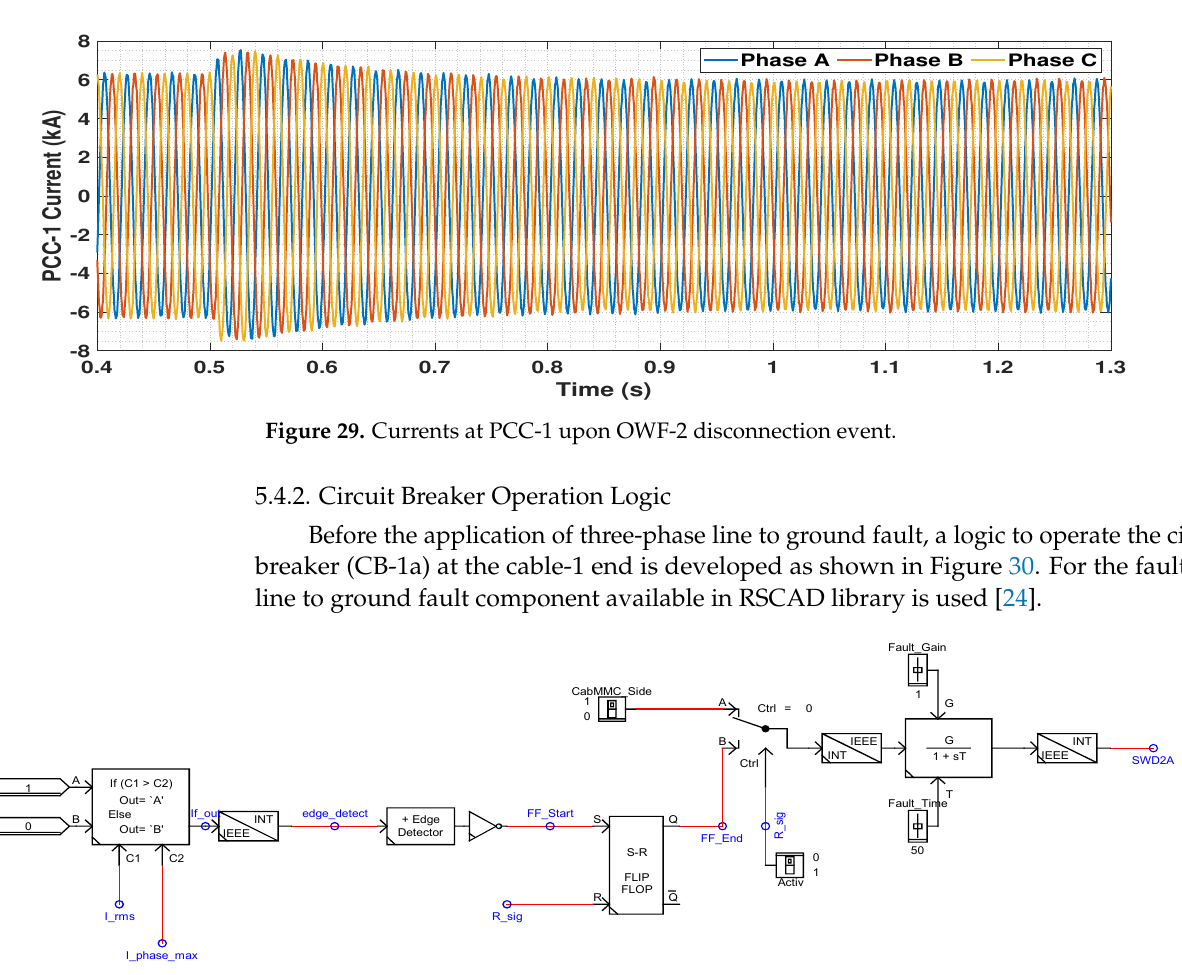
Figure 30. Circuit breaker operation